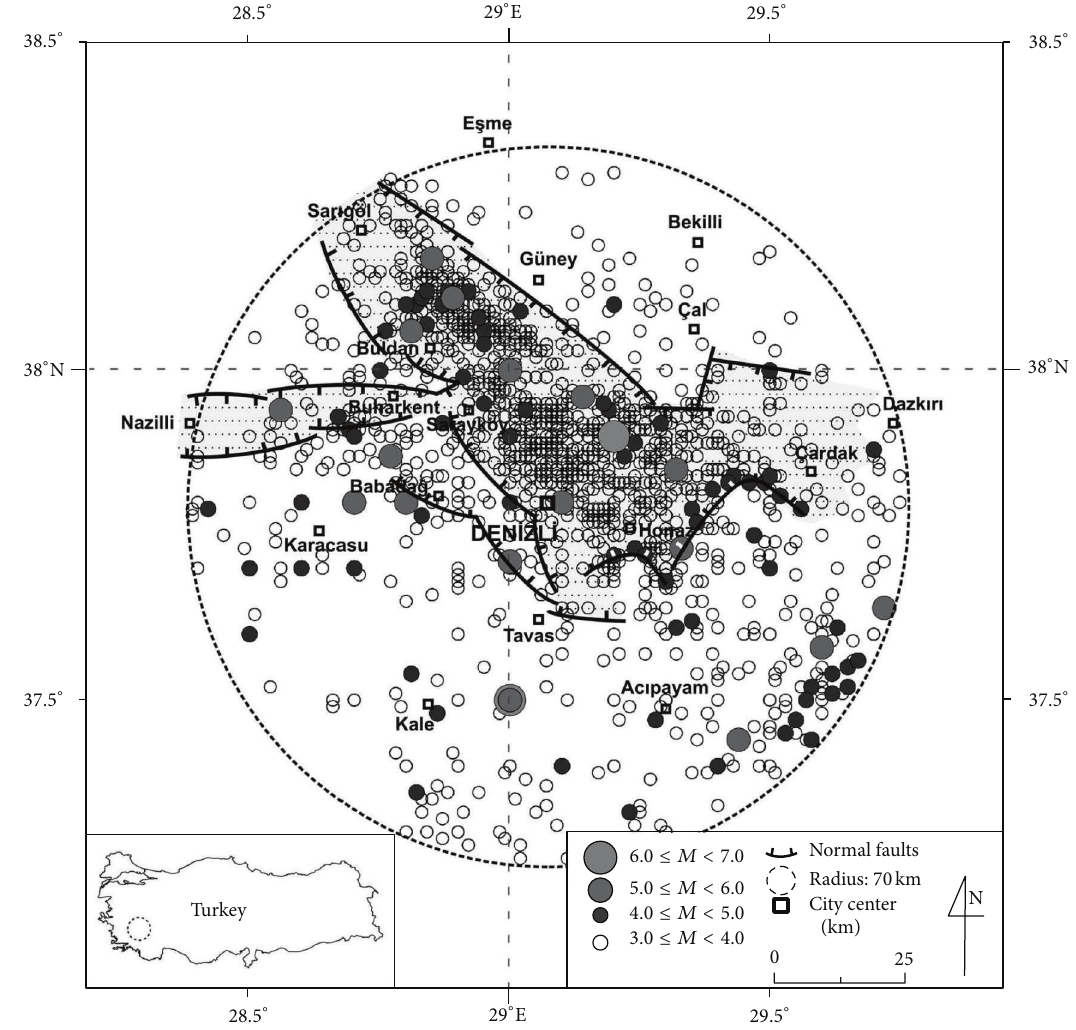
Figure 7: Distribution of the earthquake epicenters (𝑀 > 3) from A.C. 60 to 2013 in the area of Denizli centered 70 km radius circle (modified from Utku [60], data from Bo˘gazic¸i University, Kandilli Observatory and Earthquake Research